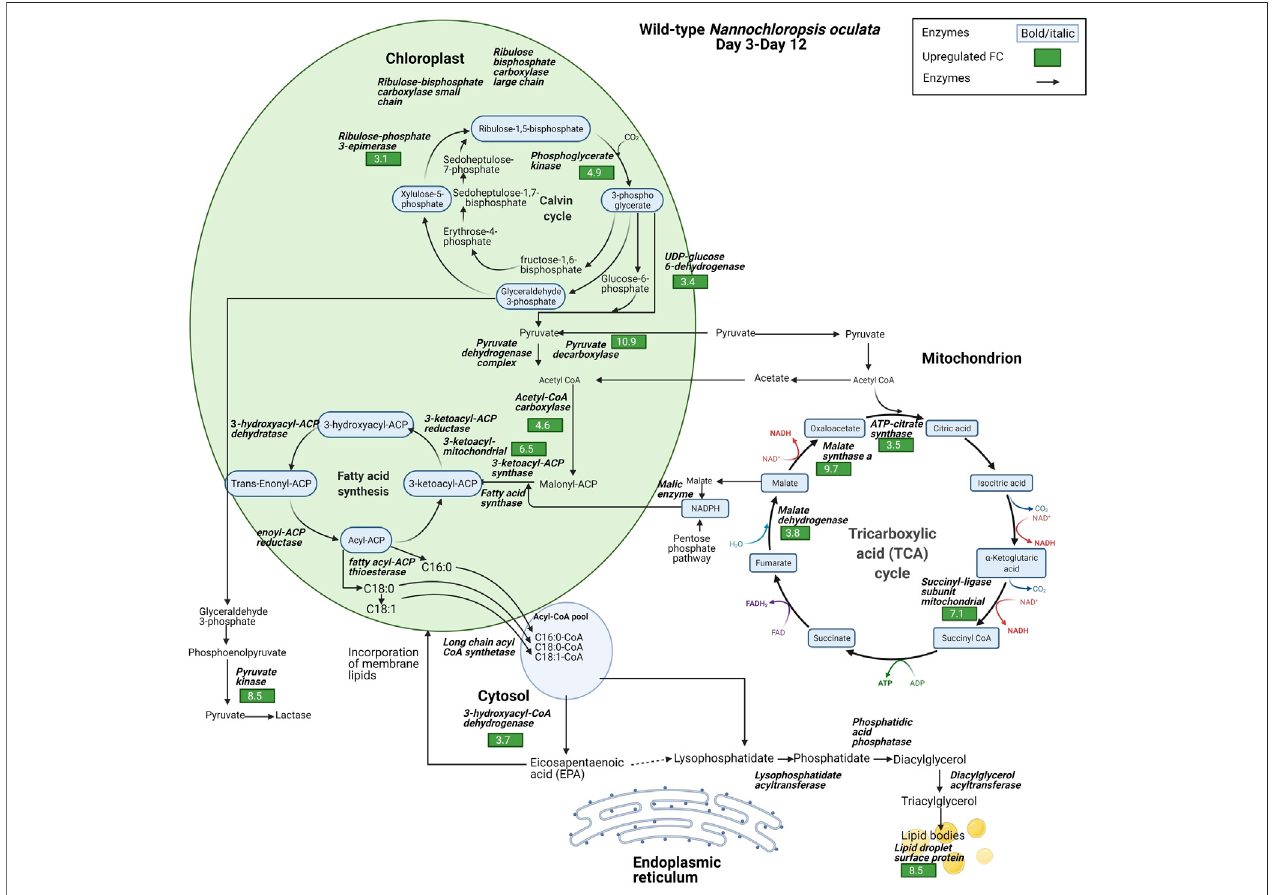
FIGURE 7 | Diagram of enzyme regulations from day 3 to day 12 for carbon fi xation toward TAG biosynthesis pathways for wild-type N. oculata . The diagram shows the pathways and their relation to fatty acid synthesis pathways. Signi fi cant quanti fi ed proteins are shown in the green and red boxes for upregulated and downregulated proteins,